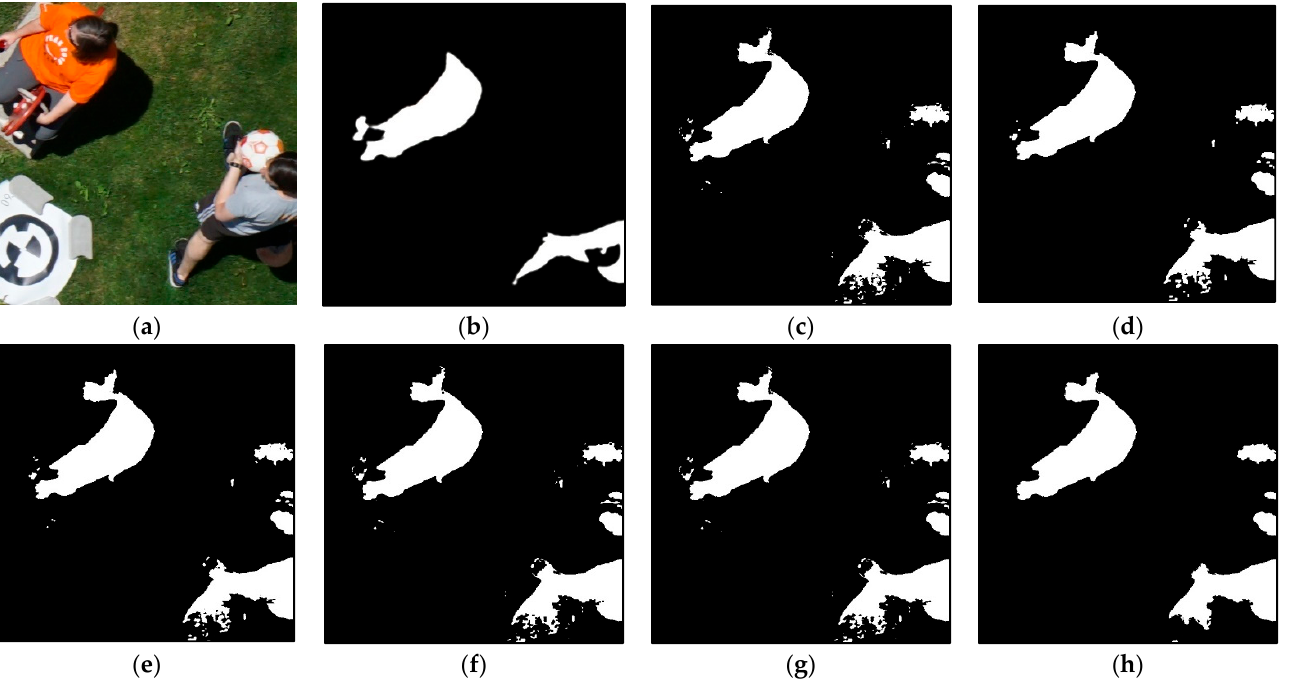
Figure 8. Visual comparison of refinement methods on Test Image 1: ( a ) input image, ( b ) ground truth, ( c ) without refinement, ( d ) opening using rectangle kernel shape ( e ), opening using cross kernel shape, ( f ) closing using rectangle kernel shape, ( g ) closing using cross kernel shape, and ( h ) dense CRF. Dense CRF performs considerably well, as most of the white noise is removed.